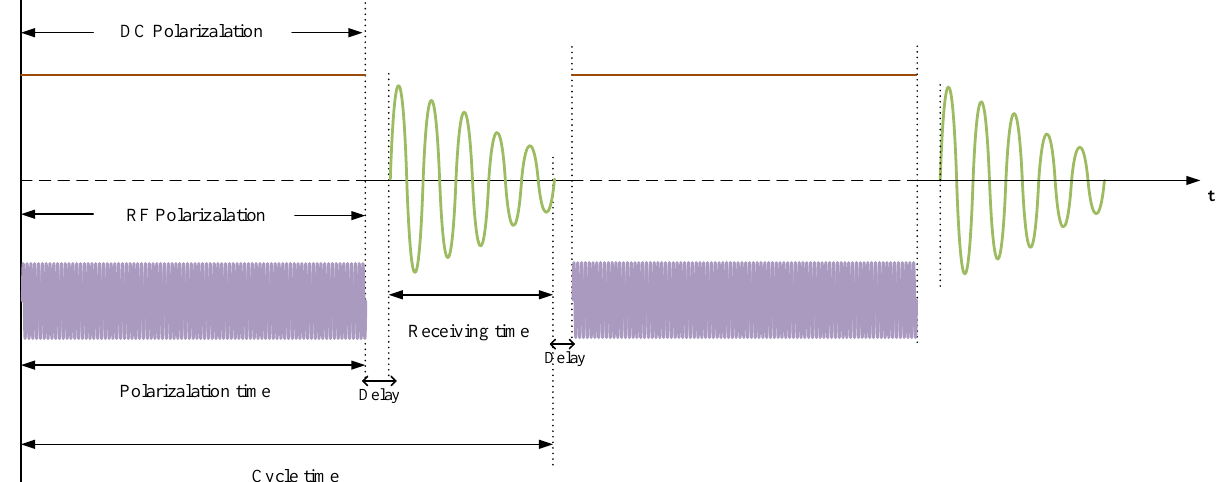
JOM-4S is a slow-reading OVM. Its cycle time can be set from 3 s to 3600 s. As shown in Figure 15, the polarization time and reception time are set to 2 and 1 s for all cycle times, respectively. DC and RF polarizations are performed at the same time.